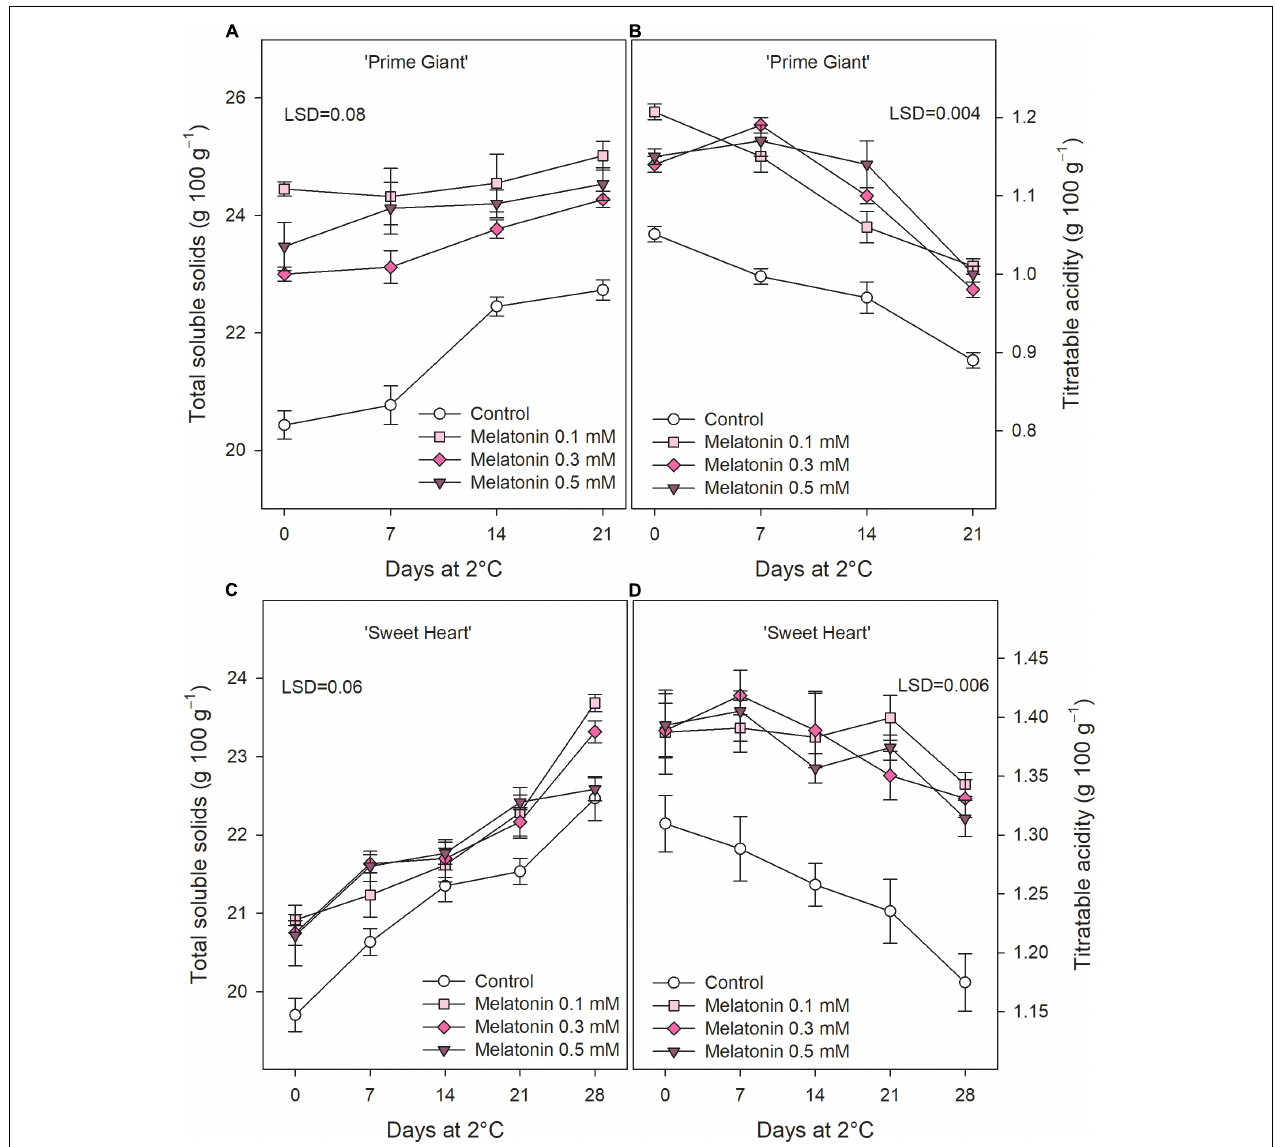
FIGURE 3 | Total soluble solids (A) and titratable acidity (B) for ‘Prime Giant’ and ‘Sweet Heart’ (C,D) cultivars during storage at 2 ◦ C as affected by melatonin pre-harvest treatments. Data are the mean ± SE of three replicates. LSD values at ( p < 0.05) are shown in each